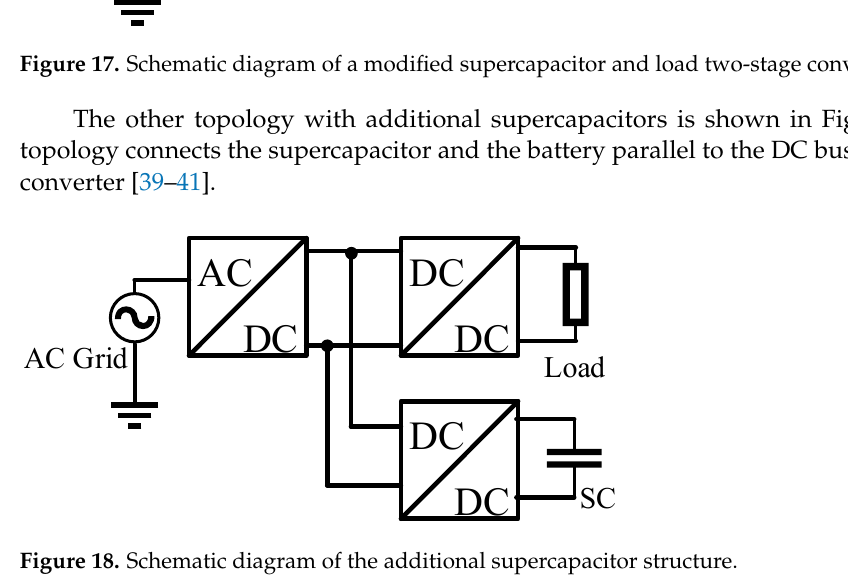
Figure 19. Schematic diagram of the plug-in converter with supercapacitor.